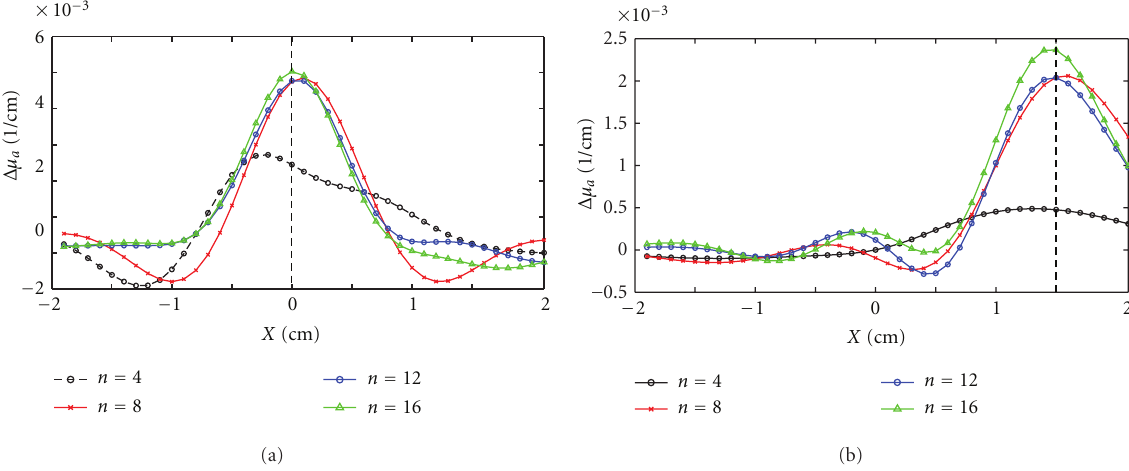
Figure 8: Profiles of reconstructed Δ μ a values along x -axis for (a) experimental Setup I and (b) experimental Setup II. Dashed vertical lines represent the actual location of the inclusion in x